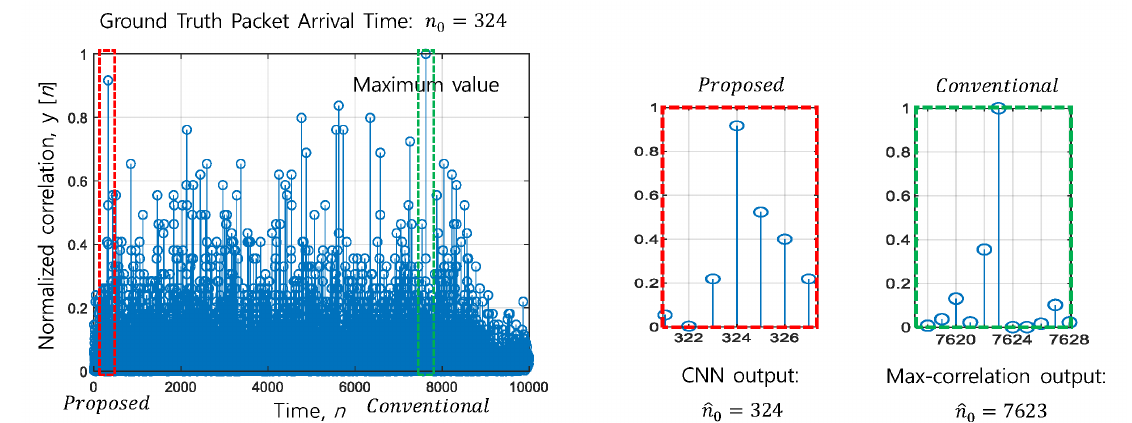
Figure 9. A case when proposed CNN method is correct but the conventional method is